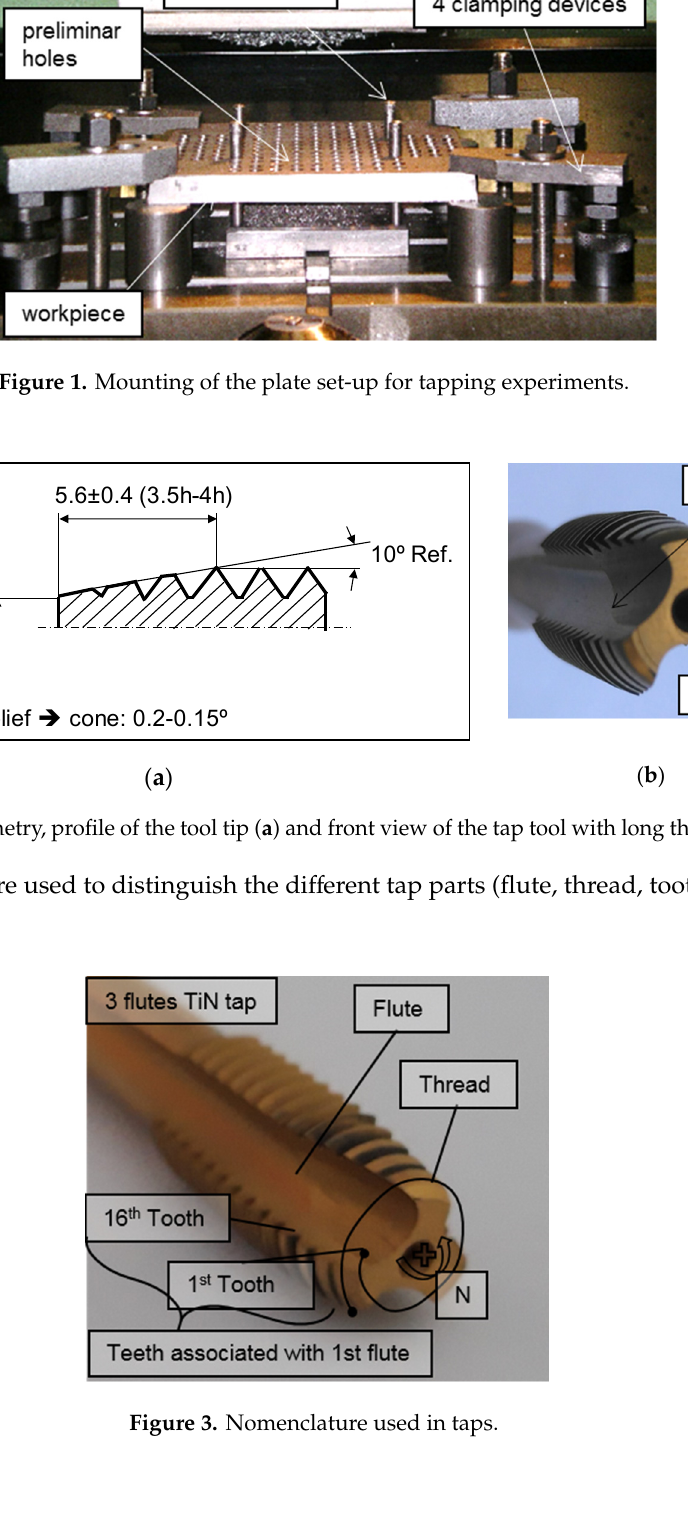
Figure 3. Nomenclature used in taps.